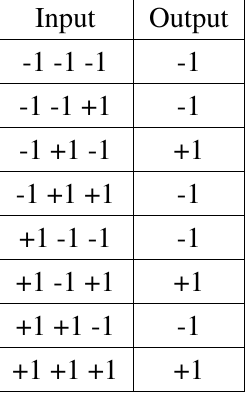
Table 1. Example of a strategy with m =